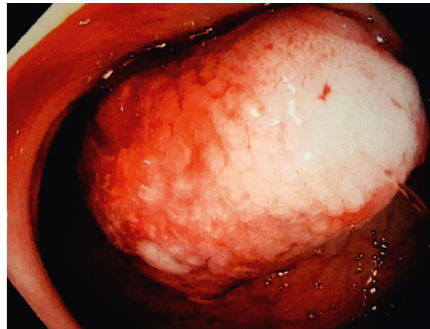
Figure 1: Endoscopic image of the PEComa showing a submucosal polypoid mass with surface ulceration located in the sigmoid